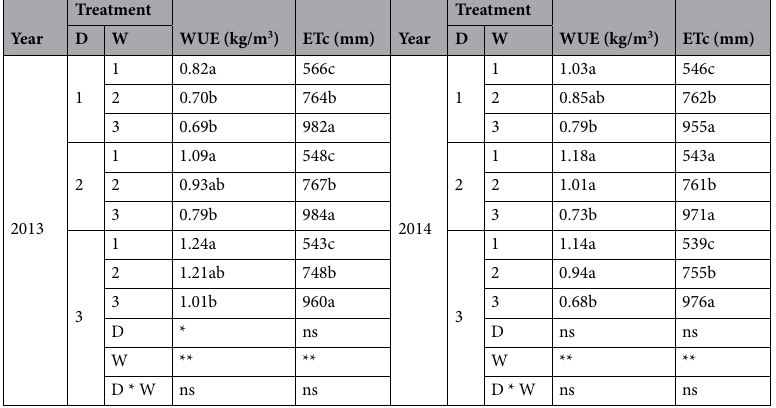
Table 5. Water use efficiency (WUE) and crop evapotranspiration (ETc) of spring wheat cultivar ‘Xinchun 6’ as affected by irrigation frequency and amount. ns represents no significance at the 0.05 probability level. *Represents significance at the 0.05 probability level. **Represents significance at the 0.01 probability level.